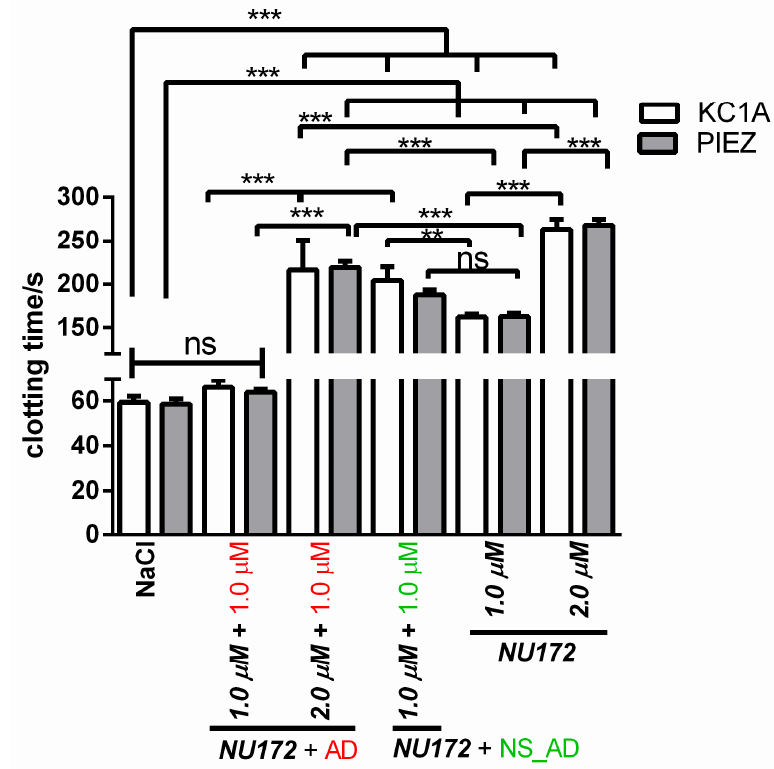
Figure 4. Detection of clotting time (CT) in citrated blood using PIEZ or ball coagulometer (KC1A). After 2 min of incubation with 1.0 or 2.0 µM NU172, 1.0 µM AD or 1.0 µM NS_AD was